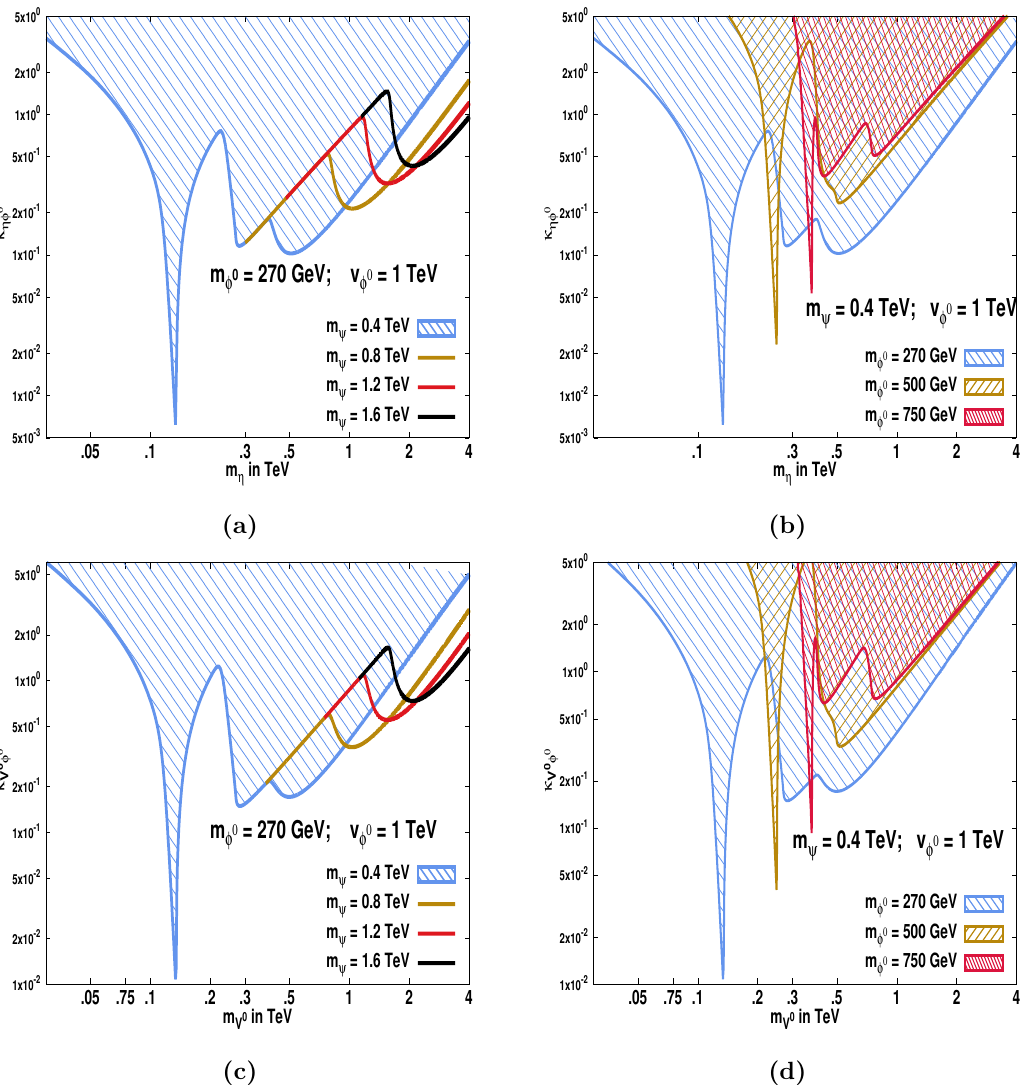
Figure 5. In the left panel we depict relic density contours satisfying (cid:10) c h 2 = 0 : 1138 (cid:6) : 0045 in the plane de(cid:12)ned by scalar (vector) DM mass m (cid:17) ( m ) and scalar (vector) DM-mediator coupling V 0 (cid:20) ( (cid:20) ) for a (cid:12)xed scalar mediator mass of 270 GeV corresponding to the four choice of VLQ (cid:17)(cid:30) 0 V 0 (cid:30) 0 masses 400, 800, 1200 and 1600 GeV respectively. In the right panel we have exhibited the constant relic density contours for a (cid:12)xed VLQ mass of 400 GeV corresponding to the three di(cid:11)erent choices of the portal scalar mass 270, 500 and 750 GeV respectively. Shaded regions appearing in blue, golden yellow and red correspond to the relic density allowed regions for the portal mass of 270, 500 and 750 GeV